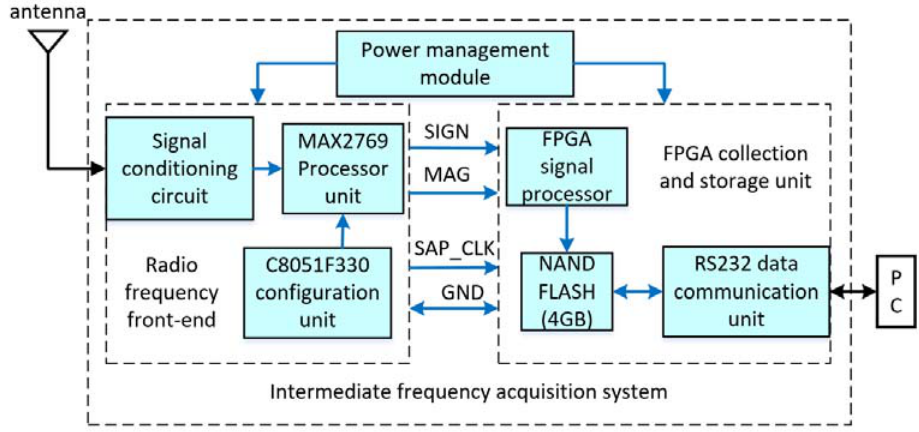
Figure 18. Block diagram of intermediate frequency (IF) acquisition system.